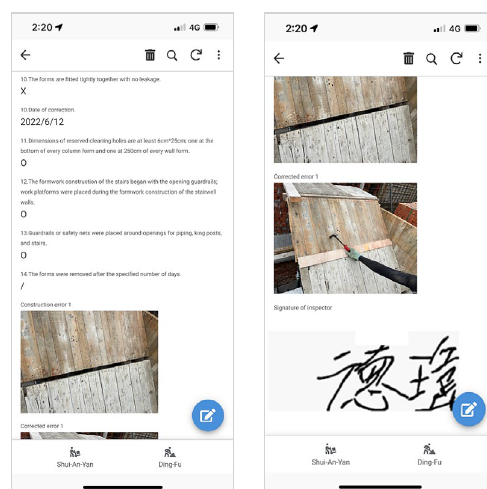
Figure 28. Results of inspection conducted by Subcontractor Y